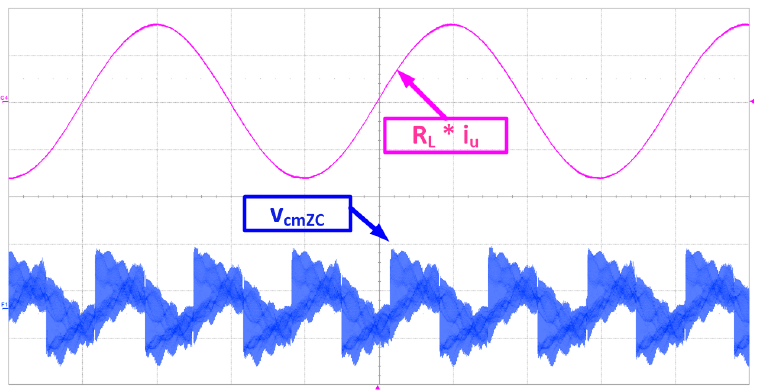
Figure 24. Experimental waveforms. R L · i u ( t ) (upper trace, 200V/div), V cmZC (lower trace, 100V/div). The time division is 5ms/div.